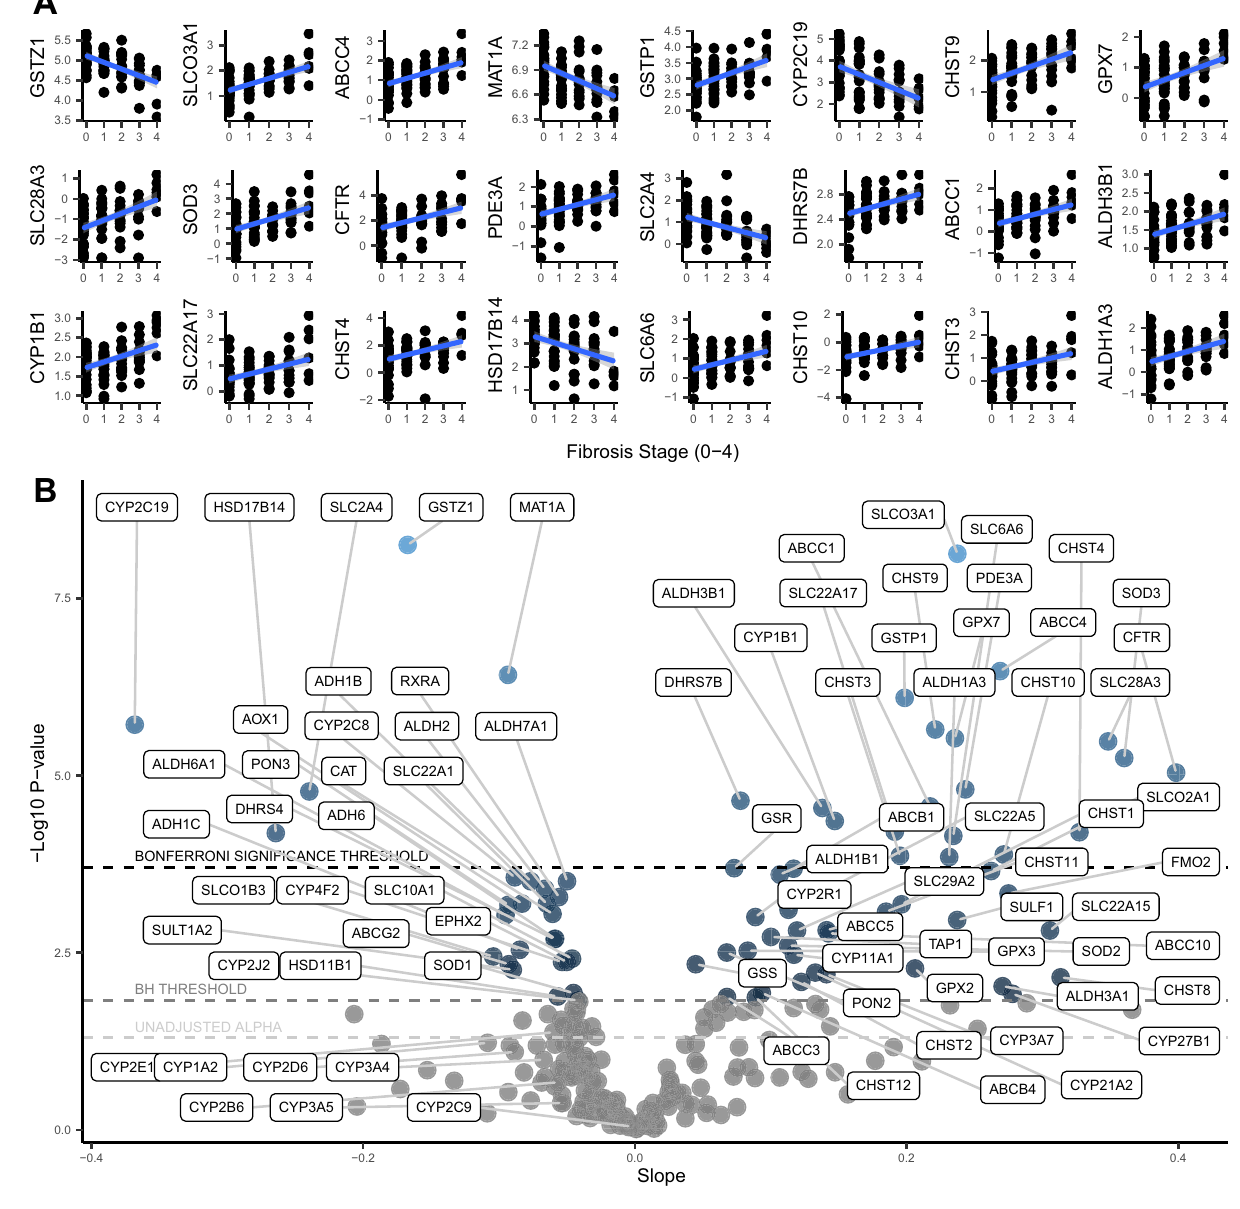
Fig. 3 | Regression results for fi brosis stage ( n =87). A Regression plots of the Bonferroni-adjusted signi fi cant correlations between fi brosis stage and pharma- cogenemRNAexpression.Lineartrendlineswere fi t(blueline)with95%con fi dence interval region (grey). B Volcano plot showing the slopes and p -values for the